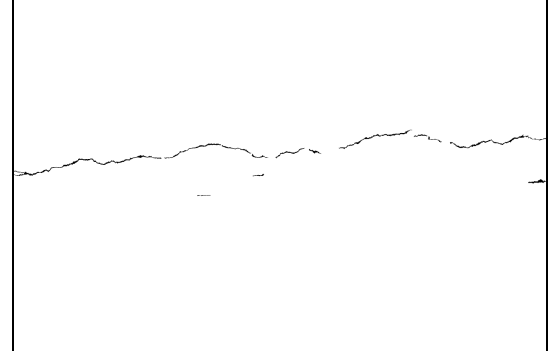
Figure 17. The result of crack detection in case 2